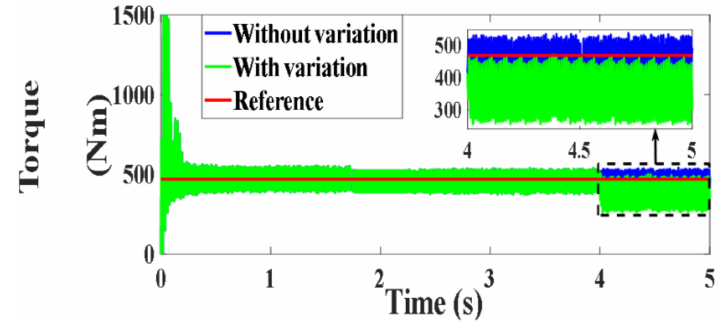
Figure 177. Developed torque under PVC (Nm).